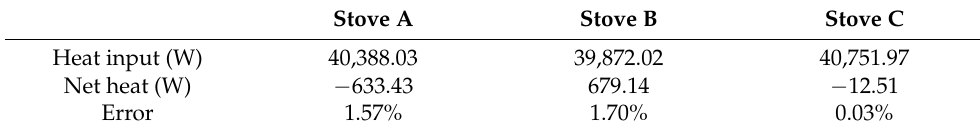
Table 2. Heat flux report at 40